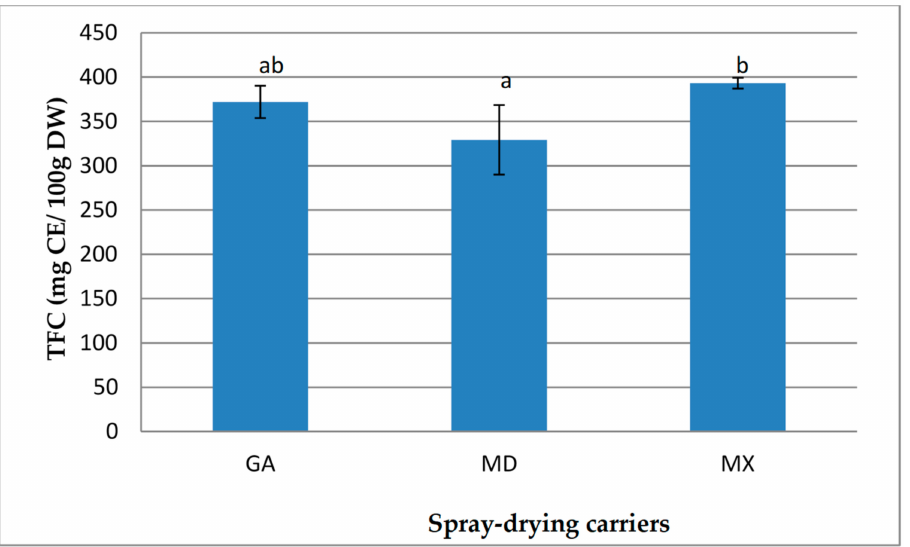
Figure 11. TFC of lemongrass leaf extract powders using different spray-dying carriers. All data are the mean ± SD. Values with different letters are significantly different ( p <